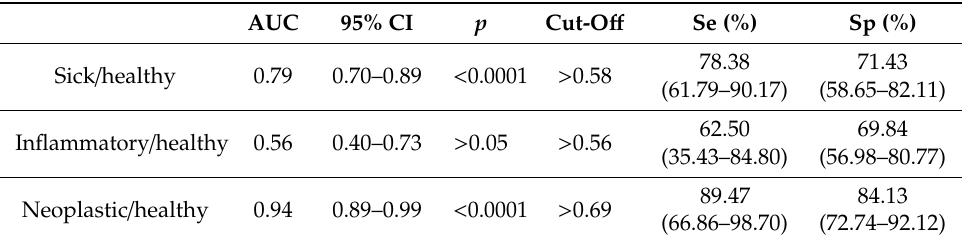
Table 3. Sensitivity and specificity of di ff erent cut-o ff points of the ratio between the aortic diameter and height of the lymph node to discriminate between sick and healthy